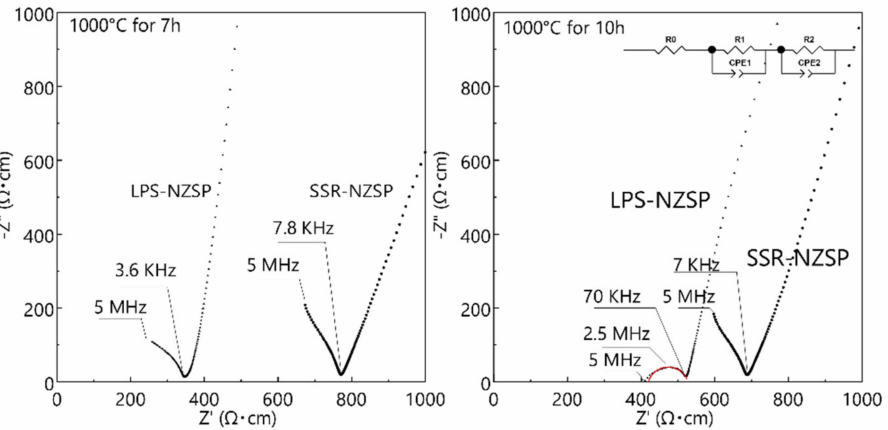
Figure 8. Nyquist plots of the samples calcined at 1000 ◦ C for 7 h and 10 h. The sampling was performed at 100 ◦ C. The red line mean fitted curve using equivalent circuit as shown in the